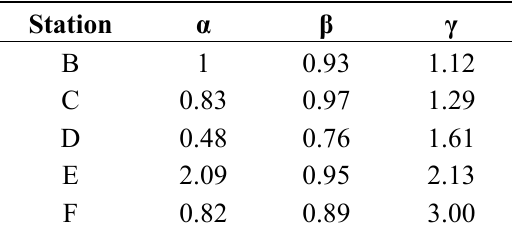
Table 7. Factors α , β and γ